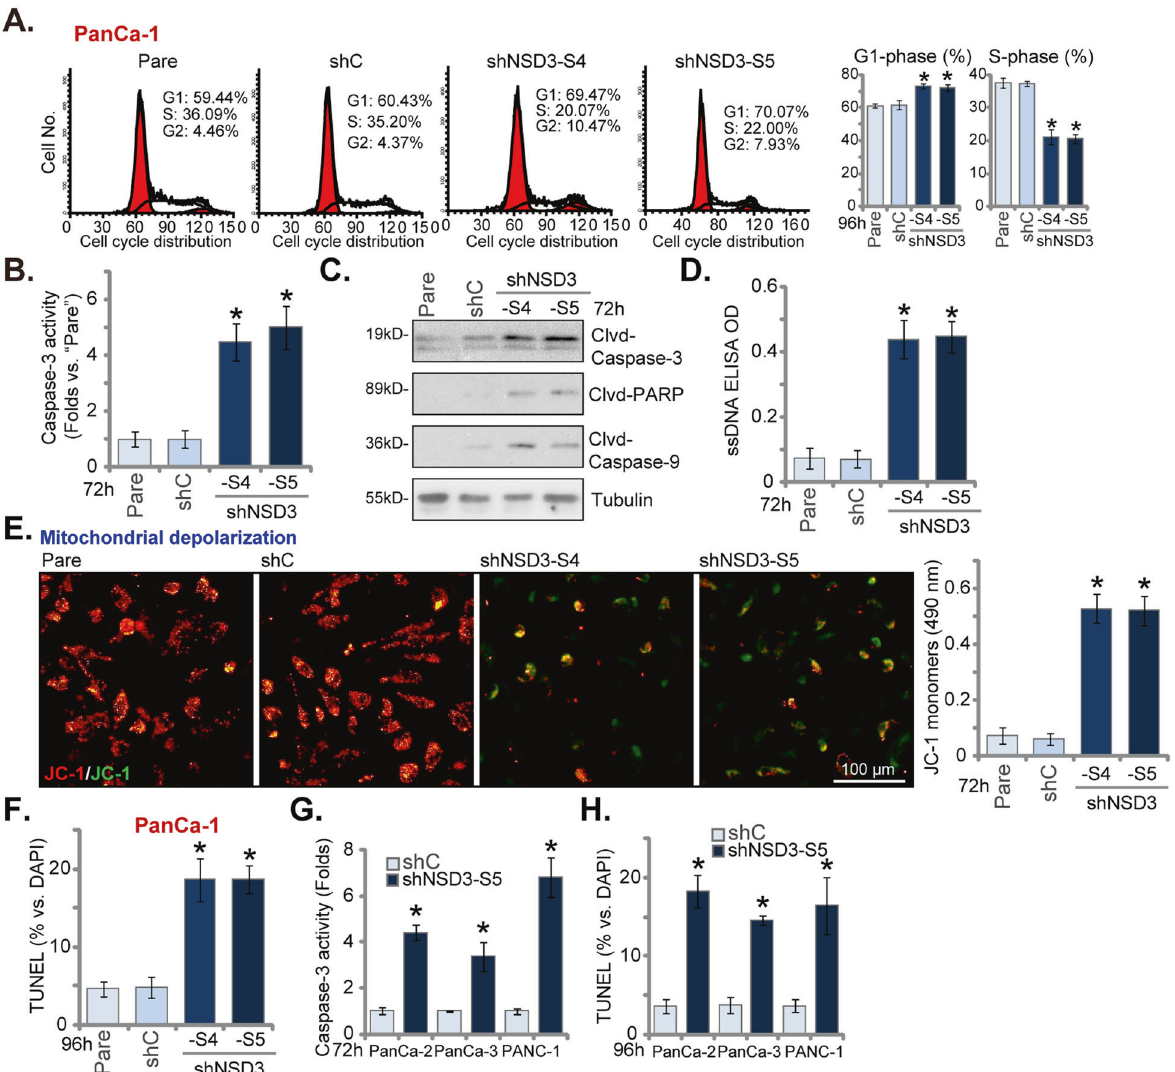
Fig. 3 NSD3 shRNA induces cell cycle arrest and apoptosis activation in pancreatic cancer cells. The primary human pancreatic cancer cells (PanCa-1/-2/-3, derived from different patients) or PANC-1 cells, stably expressing applied NSD3 shRNA or scramble control shRNA ( “ shC ” ), were established and cultured for applied time periods. Cell cycle distribution was detected by PI-FACS assays ( A ); caspase-3 activity ( B , G ), expression of apoptosis-related proteins ( C ) and single stand DNA (ssDNA) contents (ELISA assays, D ) were tested; JC-1 dye assays were performed to examine mitochondrial depolarization, and JC-1 green monomer fl uorescence intensity was quanti fi ed ( E ); cell apoptosis was tested by nuclear TUNEL staining ( F , H ). “ Pare ” stands for the parental control cells. Data were presented as mean ± standard deviation (SD, n = 5). * P < 0.05 vs. “ shC ” cells. Experiments in this fi gure were repeated fi ve times with similar results obtained. Scale bar = 100 μ m ( E